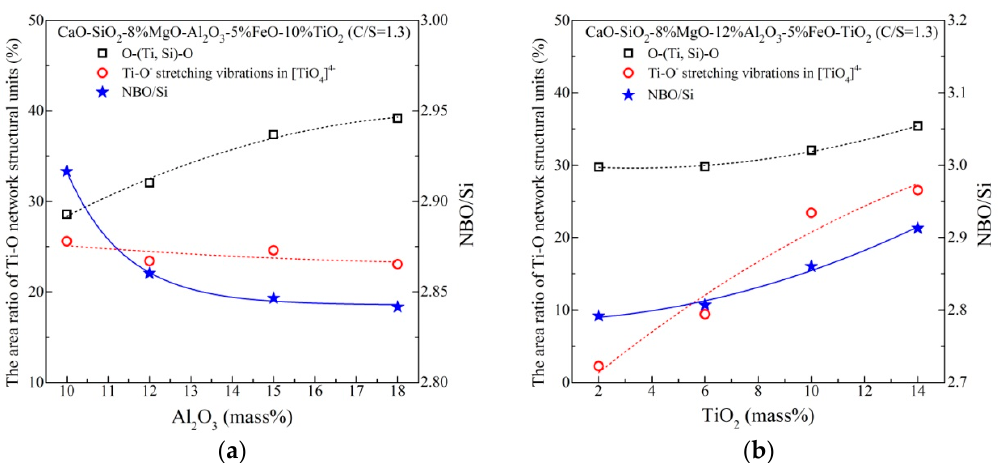
Figure 9. Typical set of Raman spectra deconvolution.